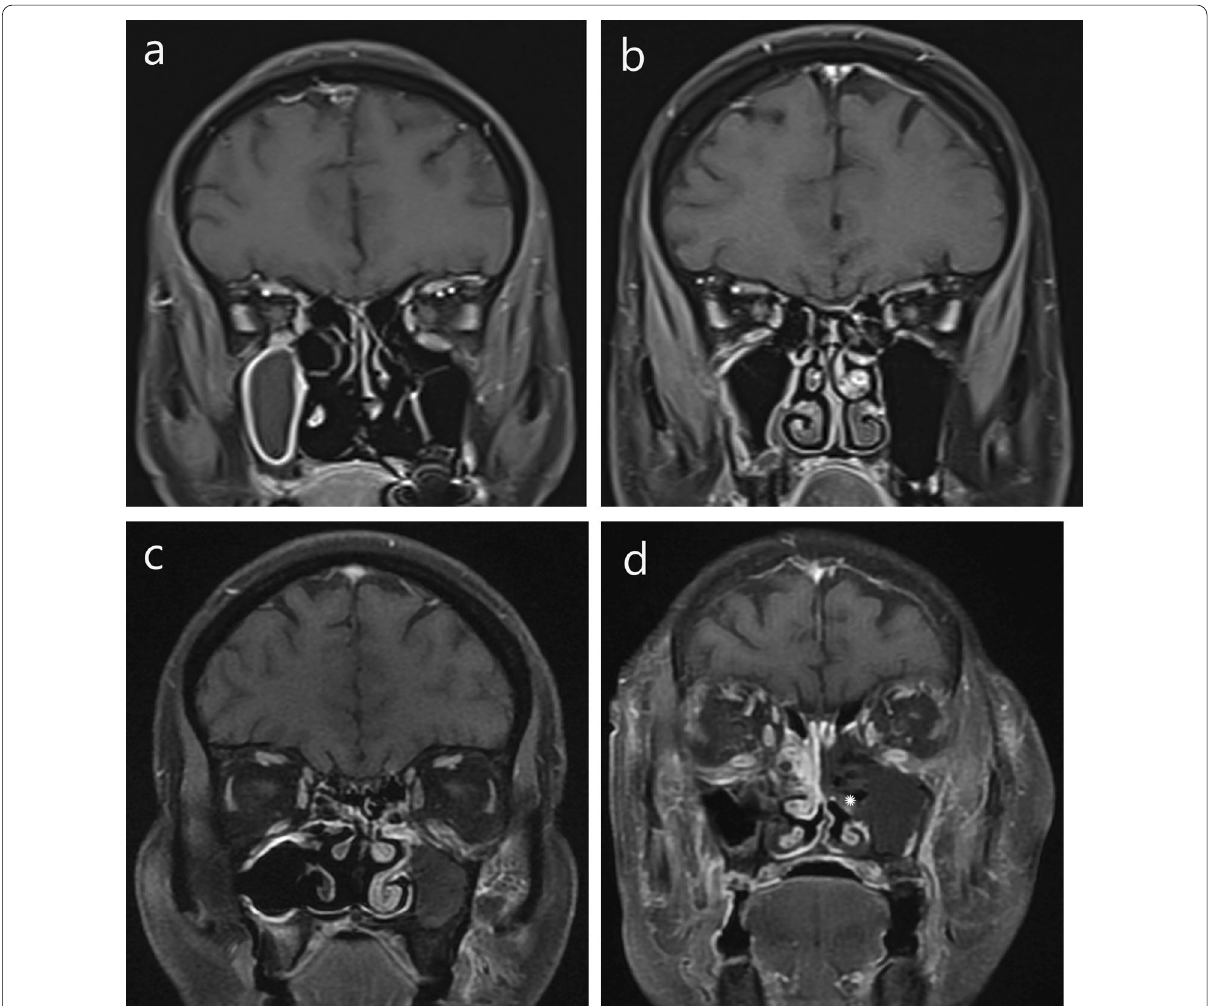
Fig. 3 Mucosal enhancement patterns on MRI in mucormycosis. T1 contrast enhanced images in coronal view of face show a intense enhancement, b patchy heterogenous enhancement and c non-enhancing maxillary sinus mucosa, d non-enhancing left middle turbinate—“Black Turbinate sign” (*). Right ethmoidal air cells mucosa show intense enhancement. Extensive inflammation is seen in bilateral extraconal orbital fat, temporal and infra-temporal fossa